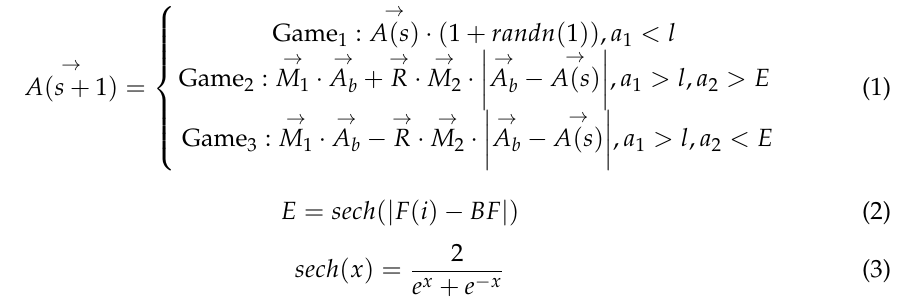
Figure 3. Schematic diagram for the histogram-based algorithm.